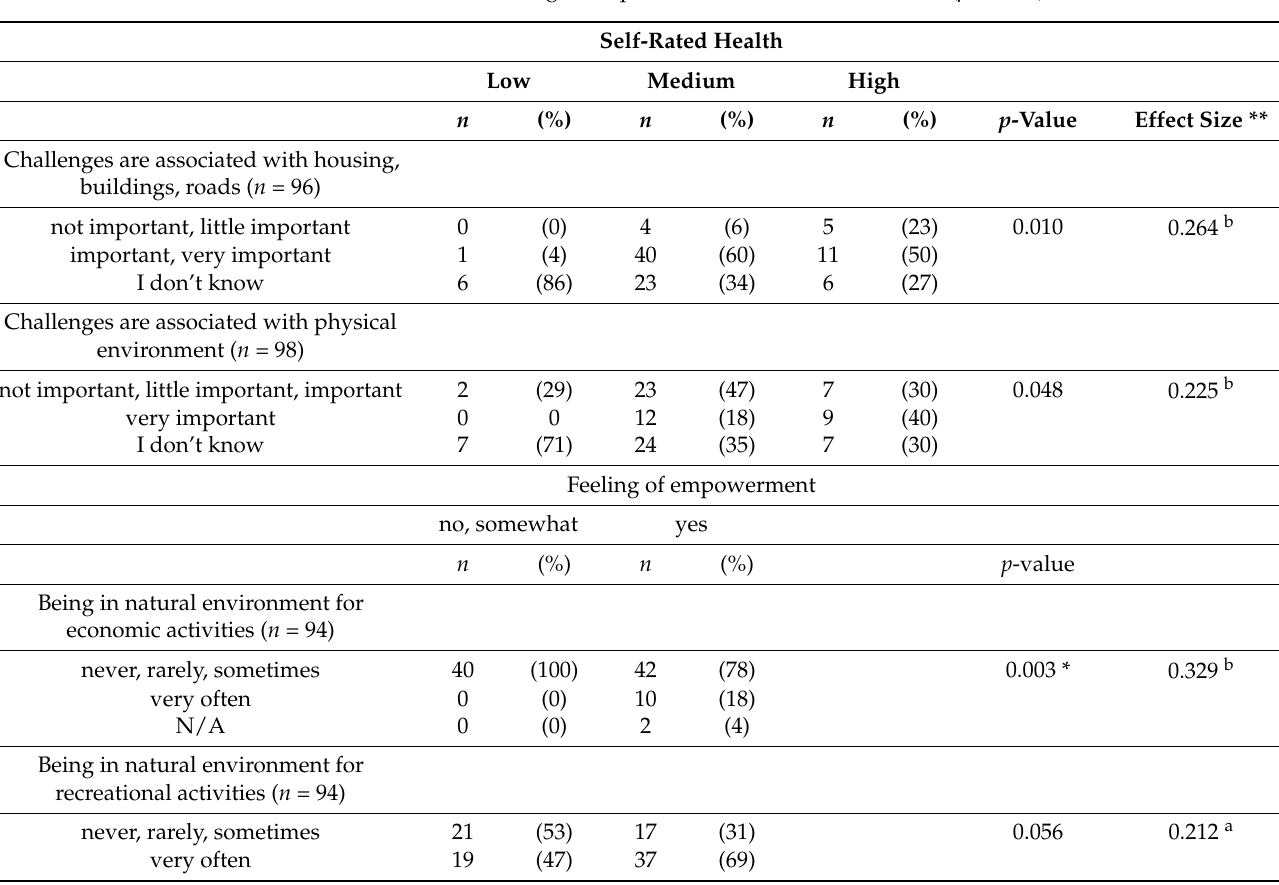
Table 2. Associations with feeling of empowerment and self-rated health ( p ≤